Question: Compose a caption that would accompany this figure in a paper.
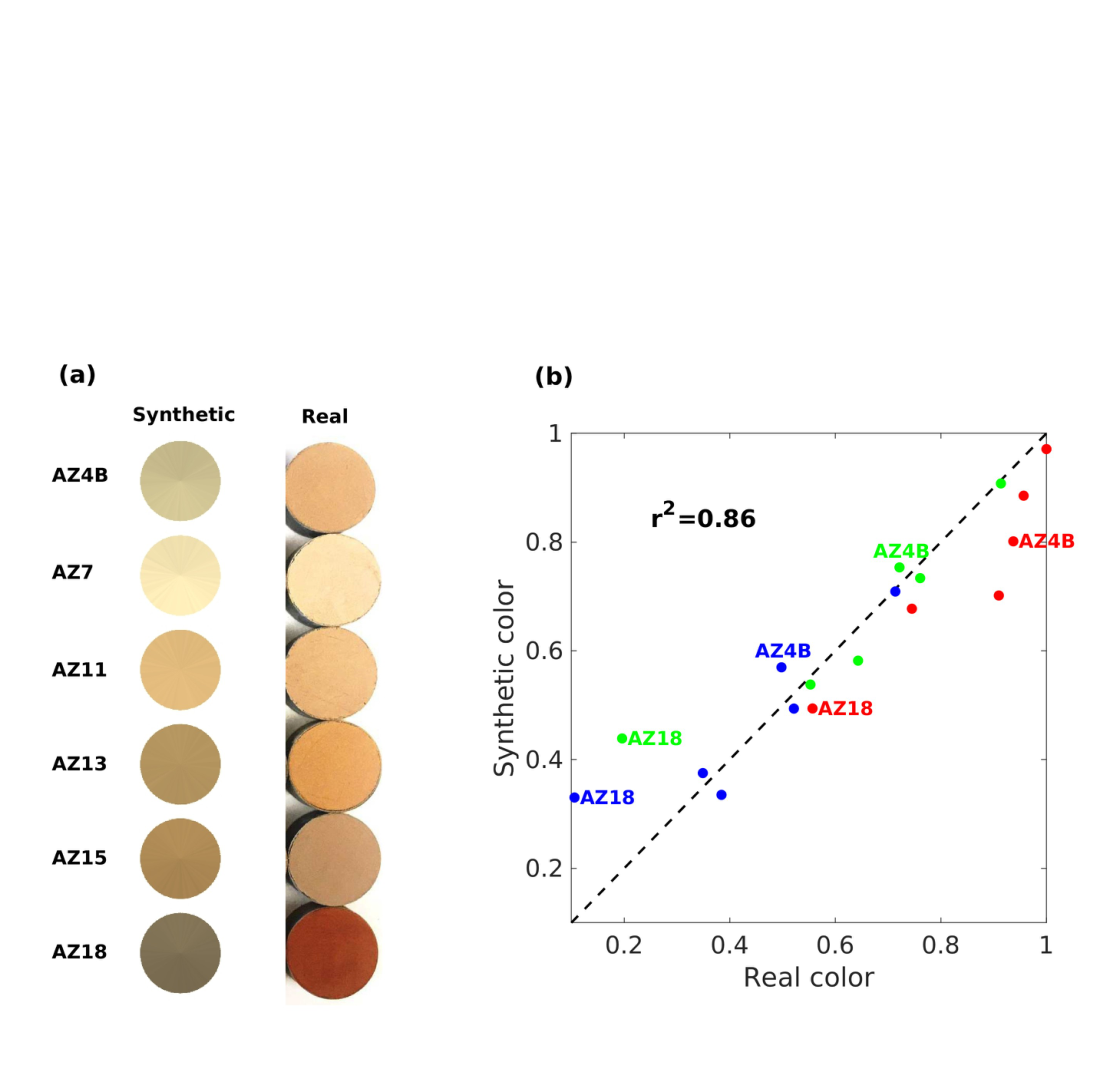
Answer: Comparison of real and synthetically generated images of soil samples with different properties. (a) Real soil images from [1] (right) compared against synthetic images generated using Helios with soil reflectance spectra generated from the SOGM (left). The synthetic image was generated based on properties provided in the original paper [1] can be found in Table 6. Sample IDs are also in accordance with those provided in the paper. (b) Real and synthetic soil RGB values represent the mean pixel values of corresponding soil sample regions, scaled from 0∼255 to 0∼1. Data points for samples AZ4B and AZ18 are labeled for comparison against the images in (a).